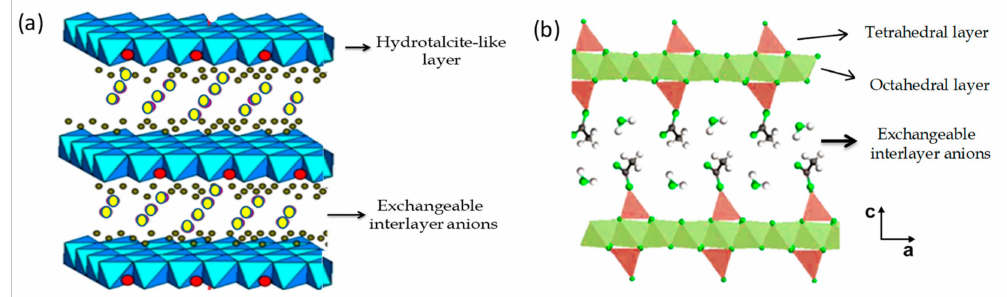
Figure 1. Schematic representation of the crystal structure of ( a ) typical layered double hydroxide (LDH) and ( b ) layered single hydroxide (LSH) layered